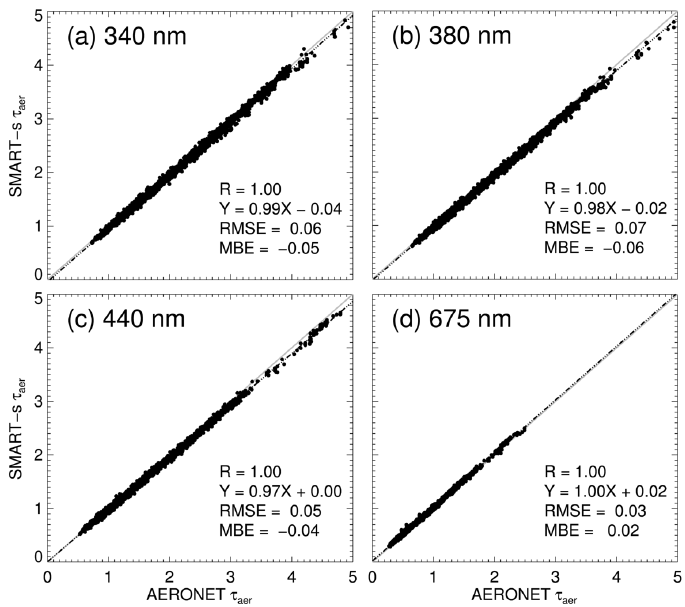
Figure A1. Comparison of aerosol optical thickness ( τ aer ) from SMART–s and AERONET (version 3, level 2.0) at (a) 340nm, (b) 380nm, (c) 440nm, and (d) 675nm measured at Fang, Thailand, from 8 March to 2 May 2019. R is the correlation coefficient, RMSE denotes the root mean square error, and MBE is the mean bias error. The black dot-dashed line and the gray solid line represent regression and one-to-one lines, respectively.